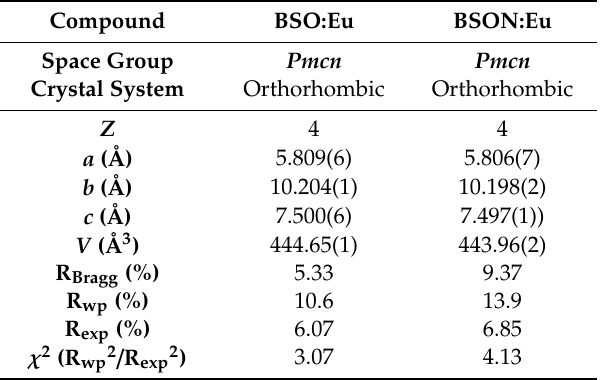
Table 1. Structural parameters for BSO:Eu and BSON:Eu. Numbers in parentheses denote the standard deviation in the last digit value.